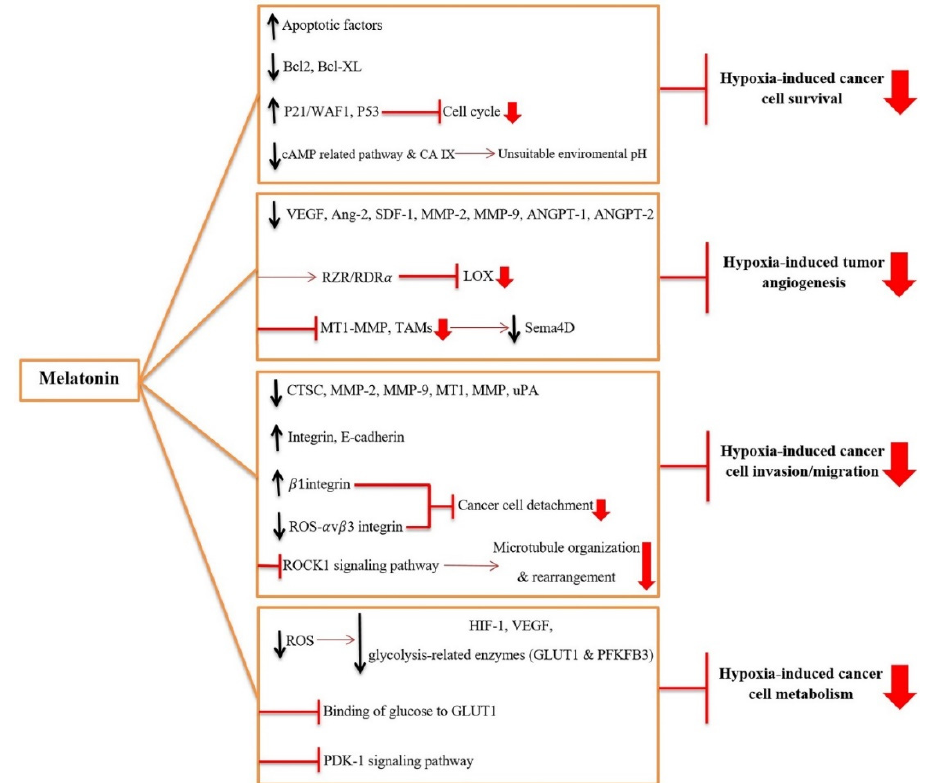
Figure 2. The mechanisms through which melatonin inhibits hypoxia-induced tumor progression. Melatonin inhibits the survival of hypoxic cancer cells by (1) up-regulating and activating the apoptotic factors, (2) down-regulating and inactivating anti-apoptotic factors [B-cell lymphoma 2 (Bcl-2) and B-cell lymphoma-extra large (Bcl-xL)], (3) blocking the cell cycle by up-regulating p21/WAF1 and p53, and (4) inhibiting carbonic anhydrase IX (CA IX) expression and activity and cAMP-related pathways to make an unsuitable environmental pH. Melatonin inhibits hypoxia-induced angio- genesis by (1) suppressing the activity of vascular endothelial growth factor (VEGF), angiopoietin- 2 (Ang-2), stromal-derived factor 1 (SDF-1), matrix metalloproteinase-2 and -9 (MMP-2 and -9), angiopoietin-1 and -2 (ANGPT-1 and -2), (2) inhibiting the expression of lipoxygenase (LOX) via in- teracting with RZR/ROR α nuclear receptor, and (3) blocking the hypoxia-induced tumor-associated macrophages (TAMs) and membrane-type 1 matrix metalloproteinase (MT1-MMP) activity and subsequently reducing Semaphorin-4D (Sema4D). Melatonin inhibits the hypoxia-induced invasion and migration of cancer cells by (1) decreasing levels of proteases including Cathepsin C (CTSC), MMP-2, MMP-9, MT1-MMP, and urokinase-type plasminogen activator (uPA), (2) up-regulating the adhesion proteins, such as integrin and E-cadherin, (3) suppressing oxidative-stress-induced detachment of cancer cells via overexpression of the β 1 integrin and down-regulation of ROS- α v β 3 integrin-FAK/Pyk2 (focal adhesion kinase/proline-rich tyrosine kinase 2) signaling pathway, and (4) blocking hypoxia-induced microtubule organization and rearrangement via blocking the Rho- kinase 1 (ROCK1) signaling pathway. Melatonin disturbs hypoxia-induced cancer cell metabolism by (1) reducing reactive oxygen species (ROS) and down-regulating hypoxia-inducible factor-1 (HIF-1), VEGF and glycolysis-related enzymes such as glucose transporter 1 (GLUT1) and progestins activate 6-phosphofructo-2-kinase/fructose-2,6-bisphosphatase 3 (PFKFB3), and (2) competing with glucose in binding to GLUT1, and 3) inhibition of 3-phosphoinositide-dependent protein kinase 1 (PDK-1) signaling